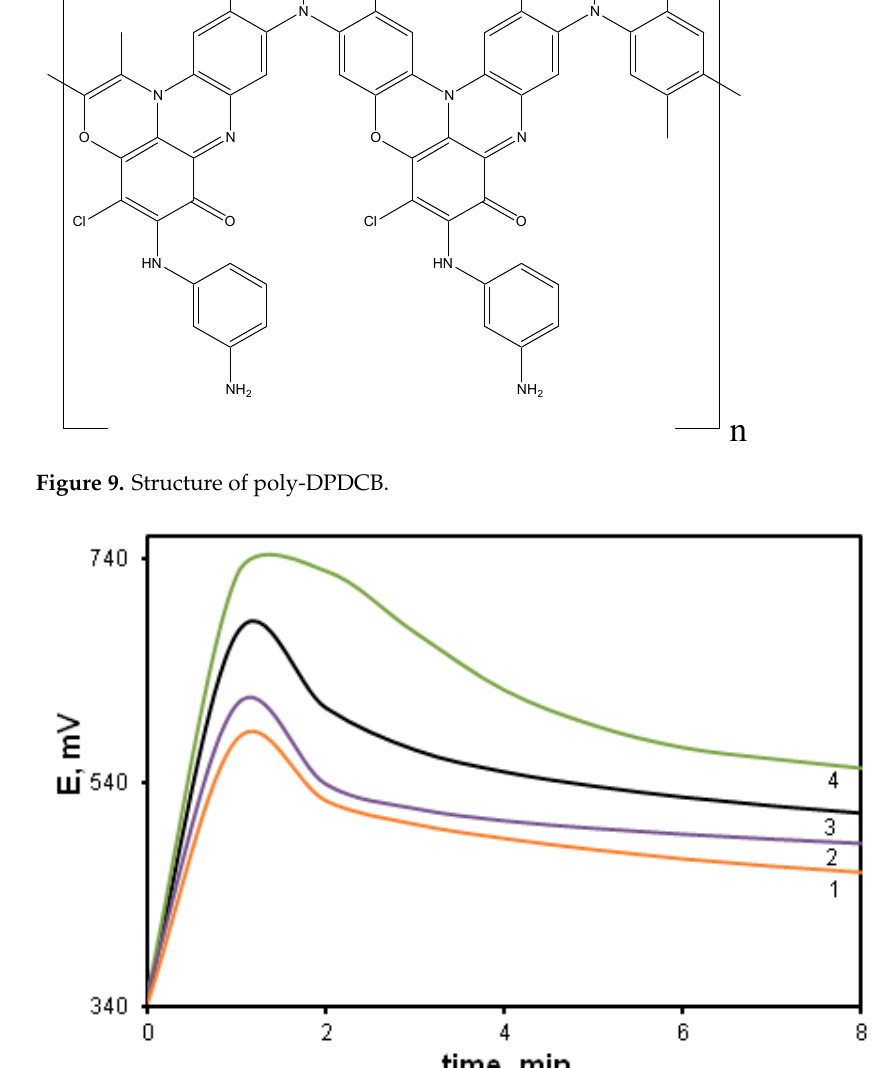
Figure 11. Time dependence of the redox potential during the DPDCB oxidation in different media: water (1), [HCl] = 0.1 mol/L (2), 0.5 mol/L (3); 1 mol/L (4). 3.3.2. Oxidative Polymerization of 2-(Aniline-3-sulfo)-5-anilino-3,6-dichloro-1,4-benzo- quinone (ASADCB) The effect of the acceptor substituent in the arylamino group was studied using the oxidative polymerization of ASADCB as an example. It is known that the presence of a sulfo group turns substituted aniline inactive in the oxidative polymerization reaction [59]. However, we carried out the polymerization of ASADCB with a sulfo group in the aniline ring. Figure 12 shows kinetic curves corresponding to the oxidative polymeriza- tion of ASADCB and, for comparison, of DADCB and MADCB.